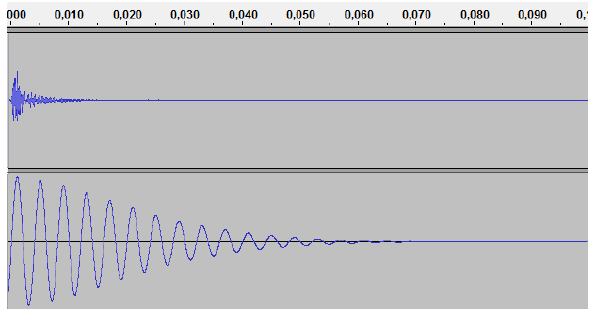
Figure 4. Signal waveforms of auditory (on the top) and haptic (on the bottom)